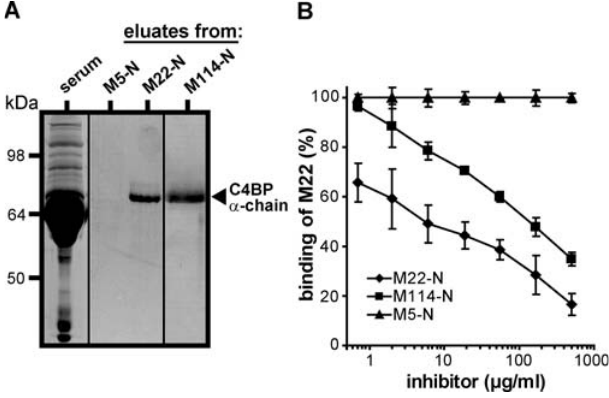
Figure 4. Characterization of the C4BP-Binding HVR in M114 (A) The HVR of M114 is a distinct protein domain that binds C4BP with high specificity. A dimerized synthetic peptide, derived from the 52 N- terminal residues in M114 and designated M114-N, was immobilized in a column. Whole human serum was passed through the column, which was washed and eluted. Control columns contained the C4BP-binding M22-N peptide or the nonbinding M5-N peptide. The eluates, and human serum, were analyzed by SDS-PAGE, as indicated. The ; 70 kDa polypeptide present in the eluates from the M22-N and M114-N columns was identified as the C4BP a -chain by Western blot analysis with specific antiserum (not shown). (B) The M114 and M22 proteins bind to the same region in C4BP. The peptides indicated were used to inhibit the binding of radiolabelled M22 protein to C4BP immobilized in microtiter wells. Data from three separate experiments with duplicate samples, presented as means 6 SD. DOI: